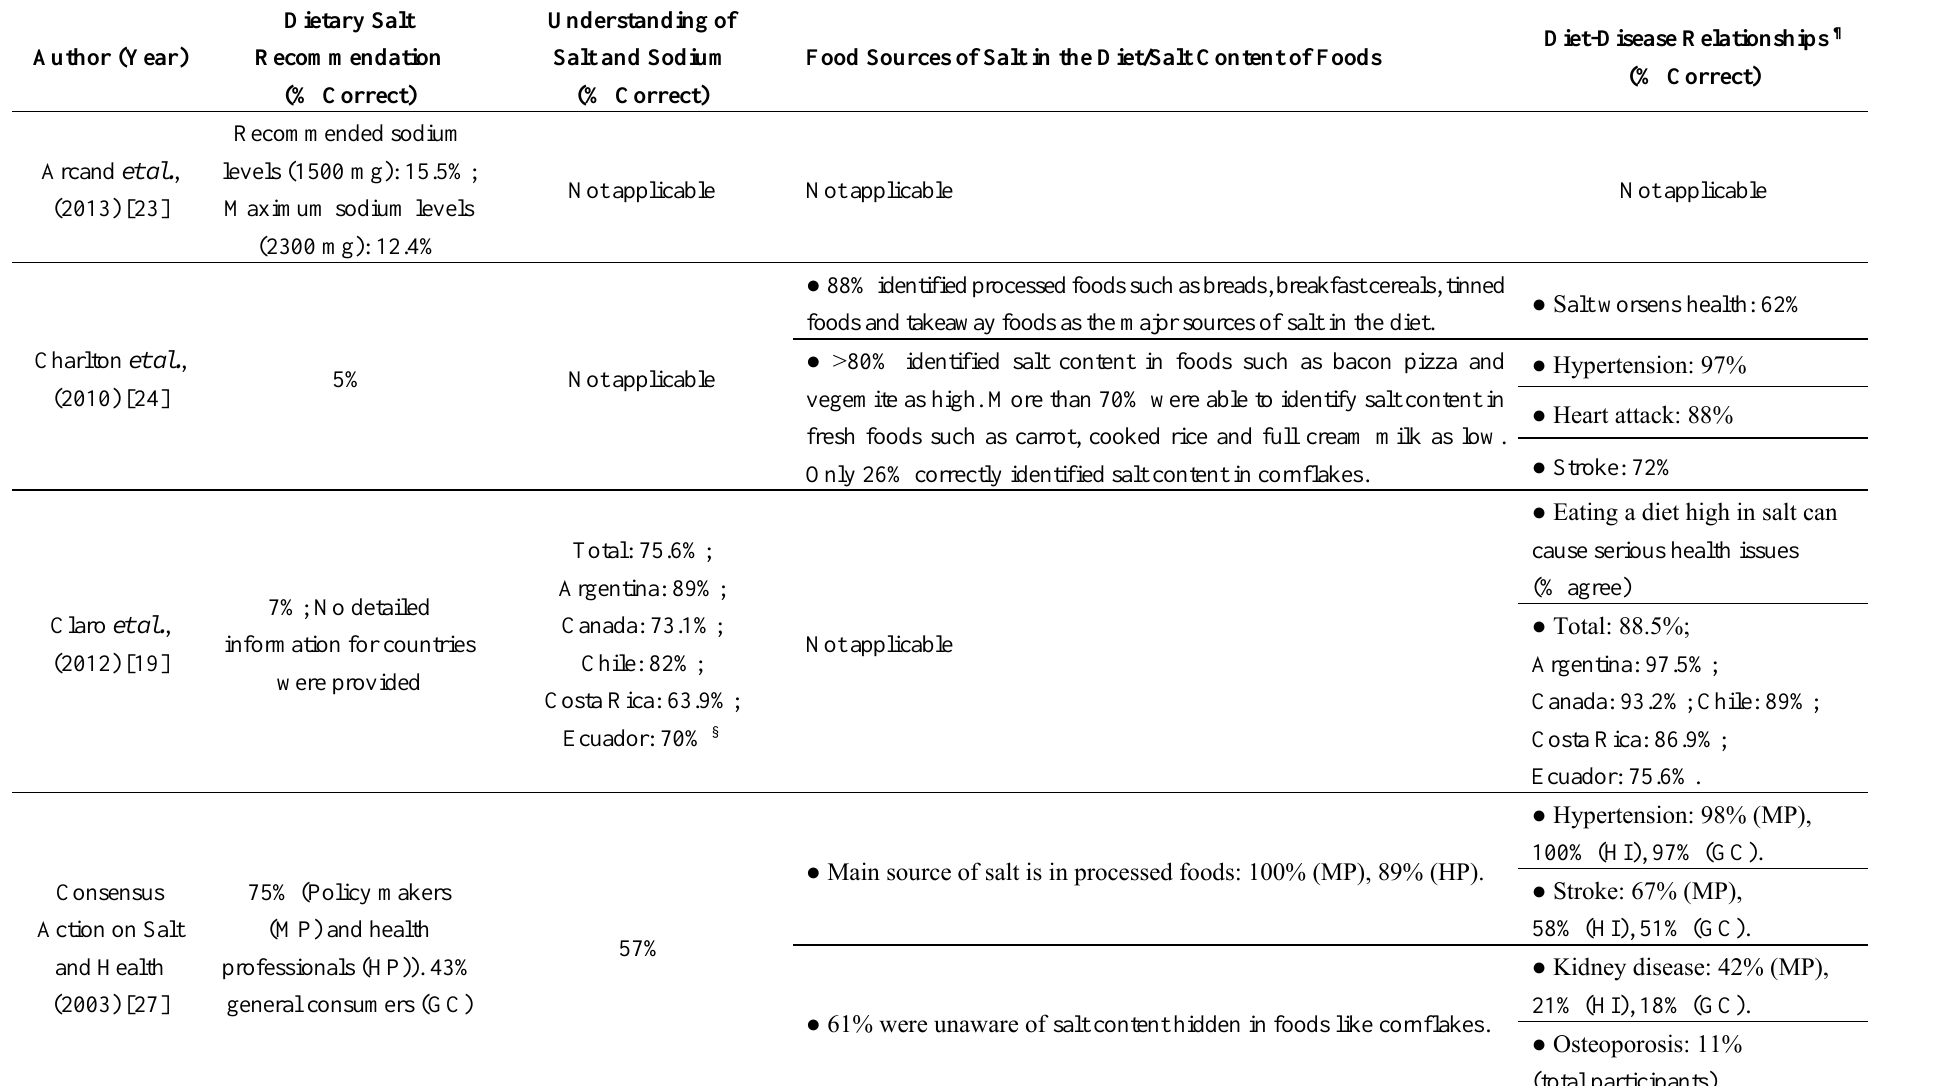
Table 2. Summary of findings on assessment of declarative salt